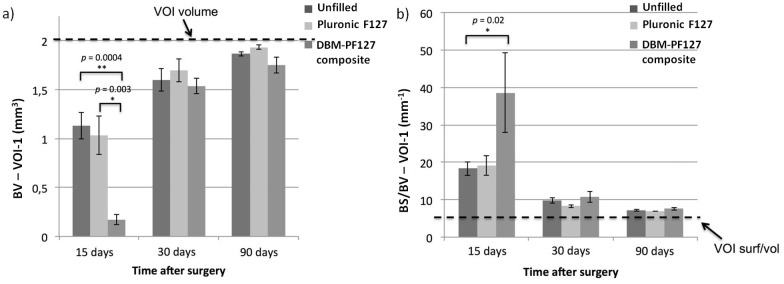
Quantitative results of bone repair as obtained with ex vivo micro-CT in VOI-1.In (a), the dashed line represents the total volume in the VOI-1 (2 mm3) which is the limit for 100% repair, whereas in (b) it is the minimum value of BS/BV for that VOI-1 (6.6 mm–1) that is only obtained when the VOI-1 is fully occupied by compact bone.